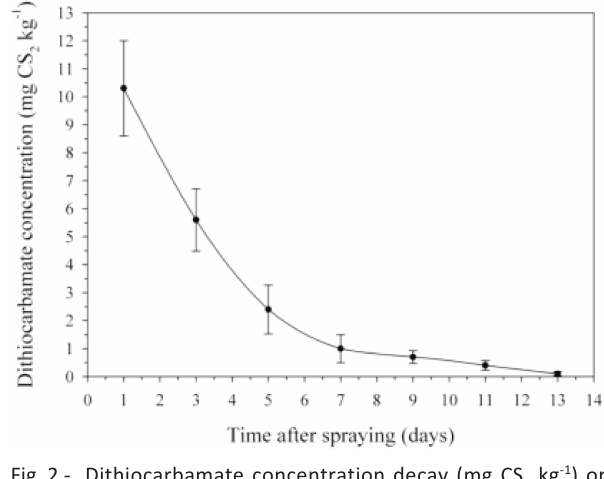
Fig. 2 ­ Dithiocarbamate concentration decay (mg CS lettuce leaves at seven intervals after mancozeb spraying. Vertical bars represent the standard error of the average values.